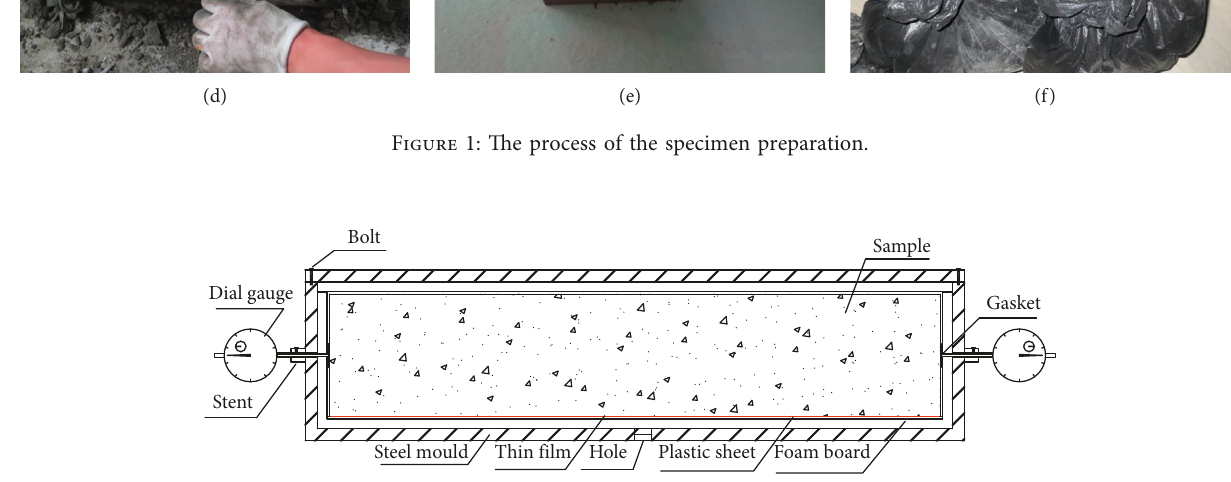
Figure 2: Expansion and contraction coupling